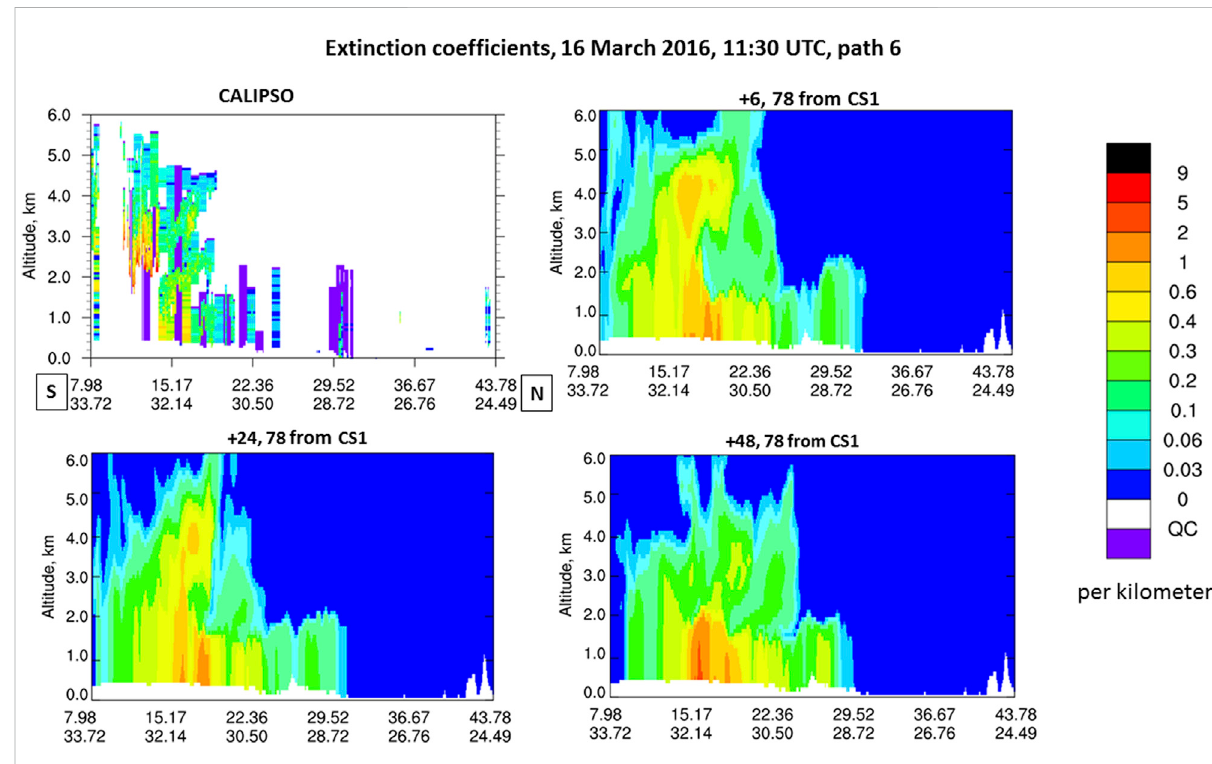
FIGURE 5 Vertical cross sections of CALIPSO and modeled extinction coef fi cients along CALIPSO Path #6 valid at 1130 UTC March 16. The modeled extinction coef fi cients in the different panels correspond to FF with different lead times and time distances from the same cold start